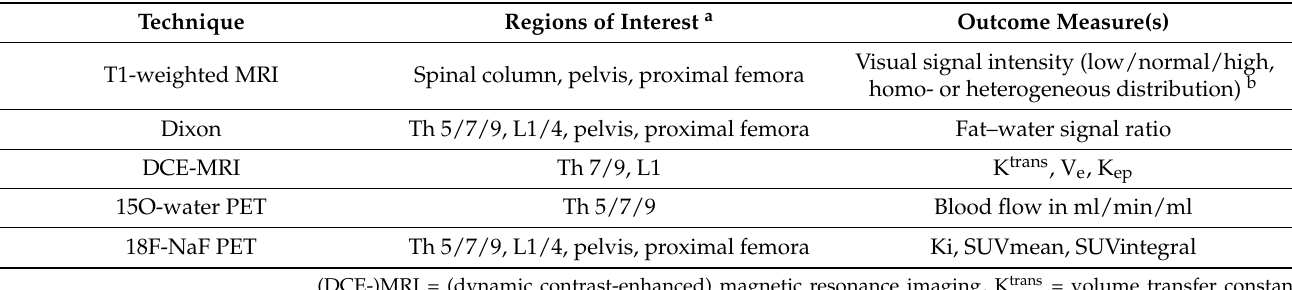
Table 1. Imaging